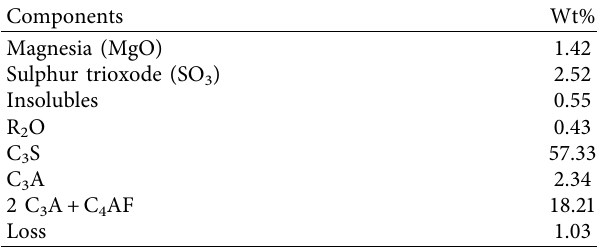
Table 1: Chemical components of class G oil well cement.